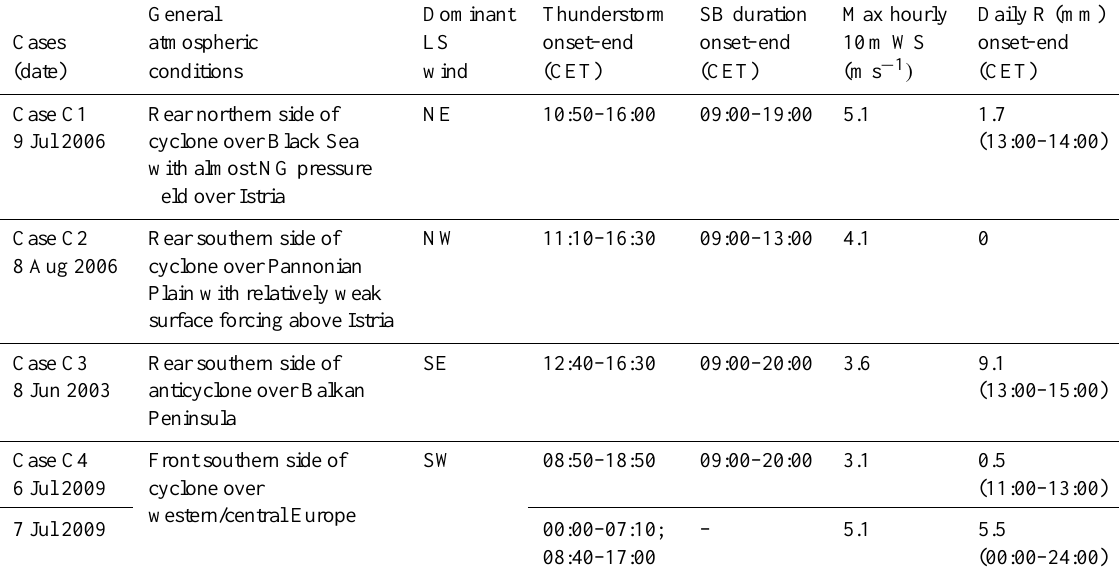
Table 1. Selected simulated WRF cases with the Cb clouds over Istria in which the SB interacts with one of the dominant types of large-scale (LS) wind (NE, NW, SE, SW). The second column displays the most dominant pressure pattern in general atmospheric conditions. Both the SB duration and wind speed (WS) were evaluated at the Pula airport site (tip of the Istria peninsula). The measured daily precipitation is for Pazin (see Fig. 1). Both onset and ending of the thunderstorms were determined on the basis of radar data. General Dominant